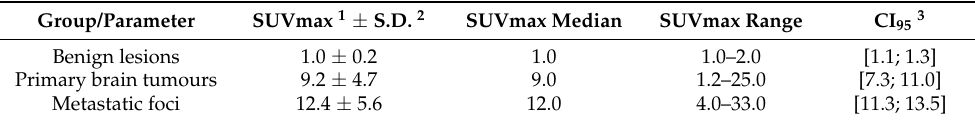
Table 2. SUVmax: benign lesions, primary brain tumours, metastatic foci (source: original data). Group/Parameter